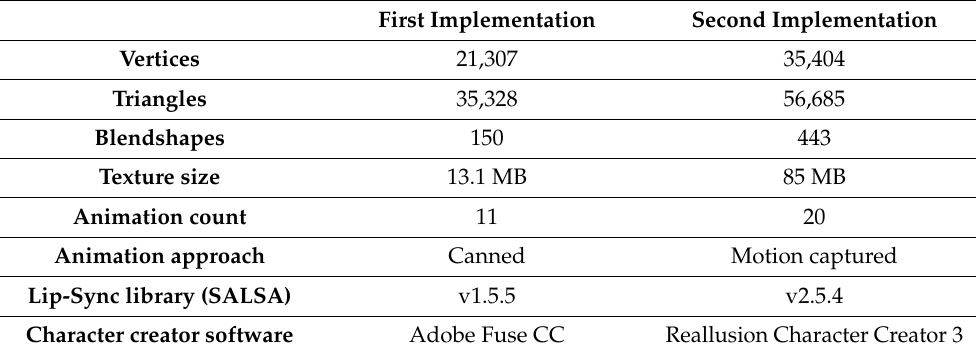
Table 1. Differences between the two VA implementations.